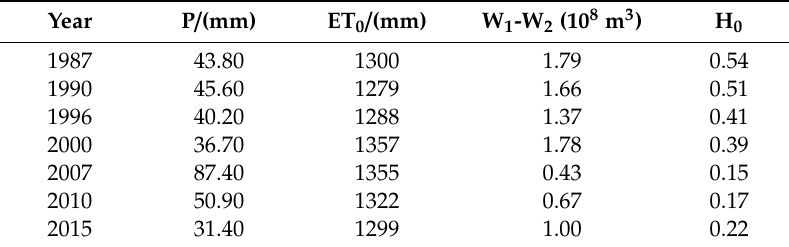
Table 5. Stability of Dunhuang Oasis.